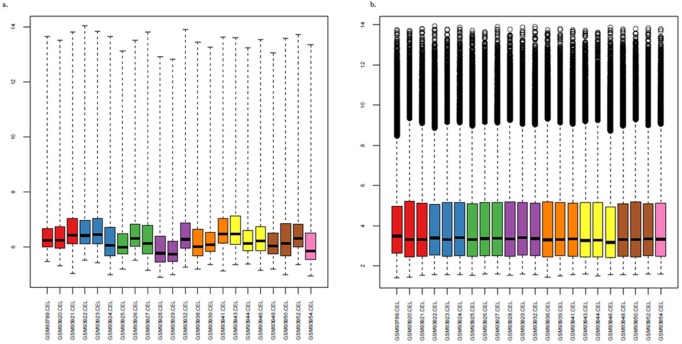
Pre-processing and normalization of DNA microarray data.2a shows the distribution of microarray files before normalization and 2b explains the uniform distribution obtained after implementing normalization i.e. removal of noise from data.